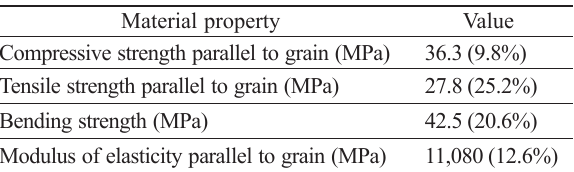
Table 1. Mechanical properties for timber obtained from testing Material property